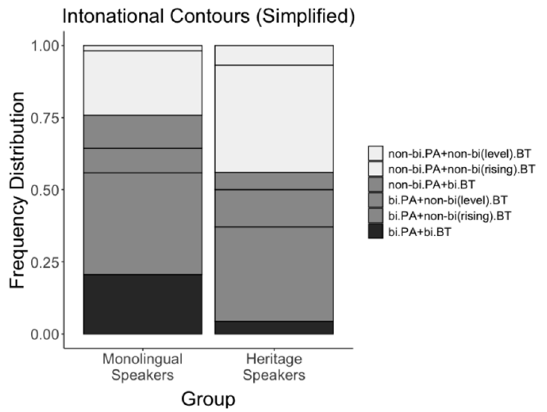
Figure 5. Frequency of simplified intonation contours (PA: Pitch accent; BT: Boundary tone; non-bi: Non-bitonal; bi: Bitonal).